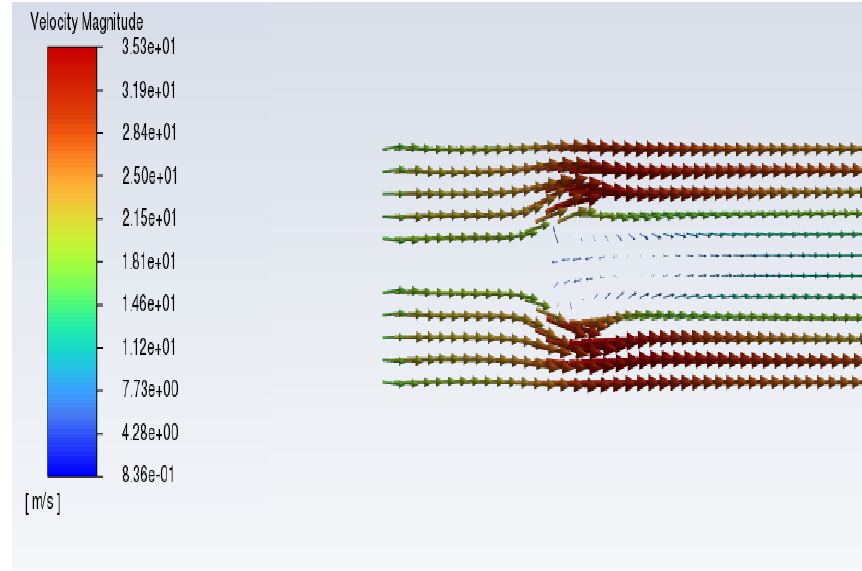
Figure 2. The contours of the computed mean velocity